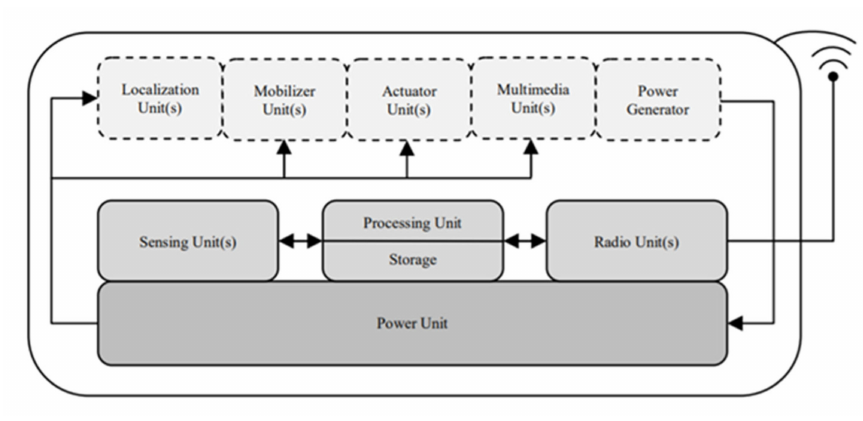
Figure 1. Sensor node architecture